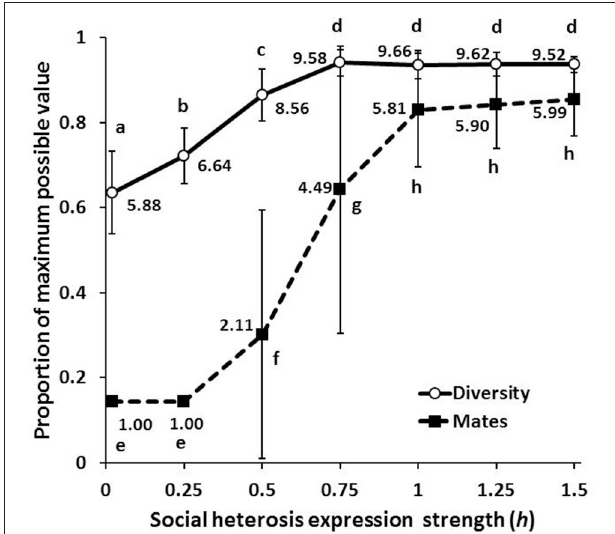
FIGURE 5 | Diversity and mate number (mean ± SD) as the relative strength of social heterosis expression ( h ) increases. Numbers give the means for each measure, letters indicate means that are not significantly different from each other by a Bonferroni-Dunn post-hoc comparison.